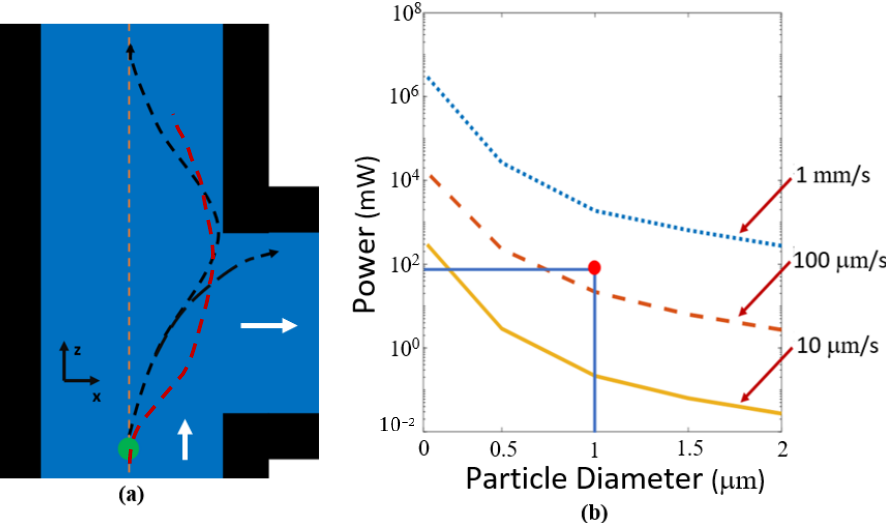
Figure 10. ( a ) Illustration of particles becoming susceptible to the fluid flow and either exiting the optofluidic region or becoming trapped. This is determined by the magnitude of the gradient force at the channel bend. These particle trajectories (black dotted arrows) closely resemble solutions to the differential equation (Equation (3)). An approximate actual particle trajectory taken from Video S2 shown by the red dotted line. The white arrows represent fluid flow direction and the orange dotted line marks the center of the channel. ( b ) Minimum trapping power versus particle size for various flow velocities at the optofluidic bend. The intersecting lines and dot demonstrate the ex- perimental conditions for our tests.